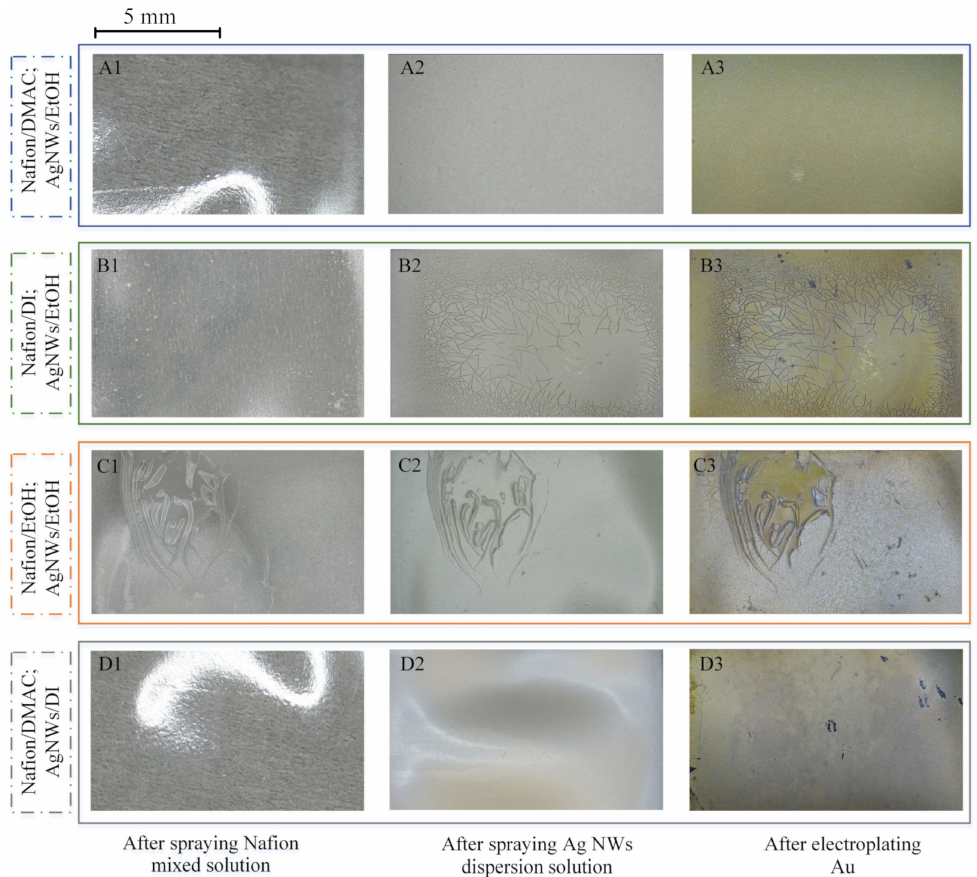
Figure 3. Surface of Au-shell-Ag-NW-based IPMC prepared based on different solvents. The letters A–D represent, respectively, the Nafion/DMAC solution and Ag NWs/EtOH solution combination, the Nafion/DI solution and Ag NWs/EtOH solution combination, the Nafion/EtOH solution and Ag NWs/EtOH solution combination, and the Nafion/DMAC solution and Ag NWs/DI solution combination. Numbers 1–3 represent the samples after spraying the Nafion mixed solution, Ag NWs dispersion solution and electroplating Au,